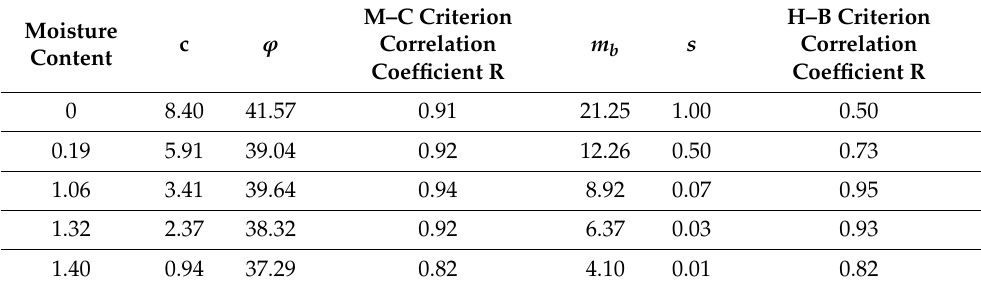
Table 2. Peak strength fitting coefficient of the yield criterion.